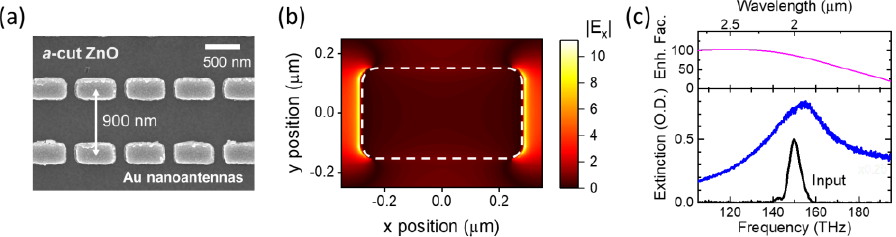
Fig. 1. (a) A SEM image of an antenna array fabricated on ZnO. (b) A simulated near-field distribution of |Ex| inside the ZnO substrate (2-nm beneath the air-ZnO interface). The dashed line shows the antenna area. (c) The measured extinction spectrum (blue) is shown with the calculated intensity enhancement factor spectrum (pink). A black line represents the input pulse